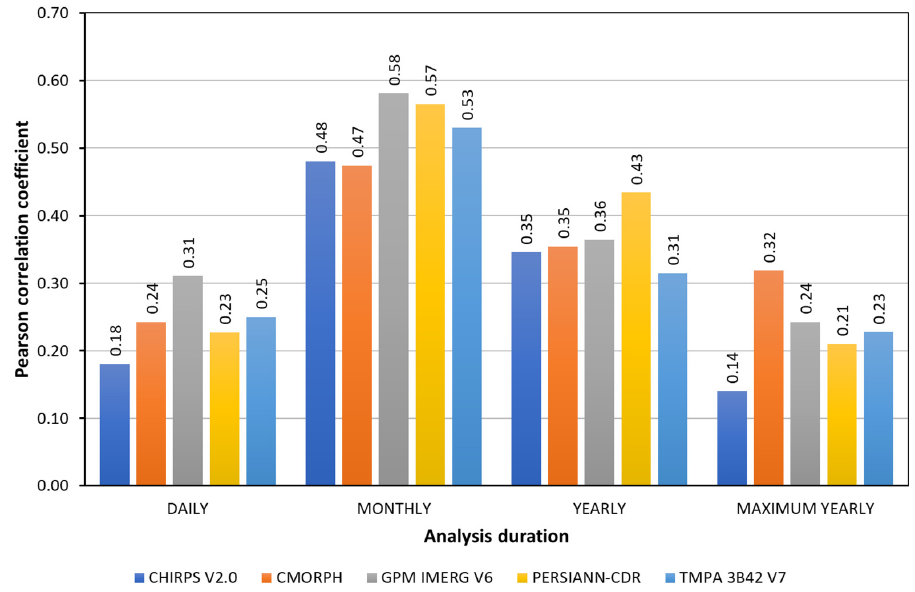
Figure 7. Variation of the Pearson correlation coefficient mean values over the study area.